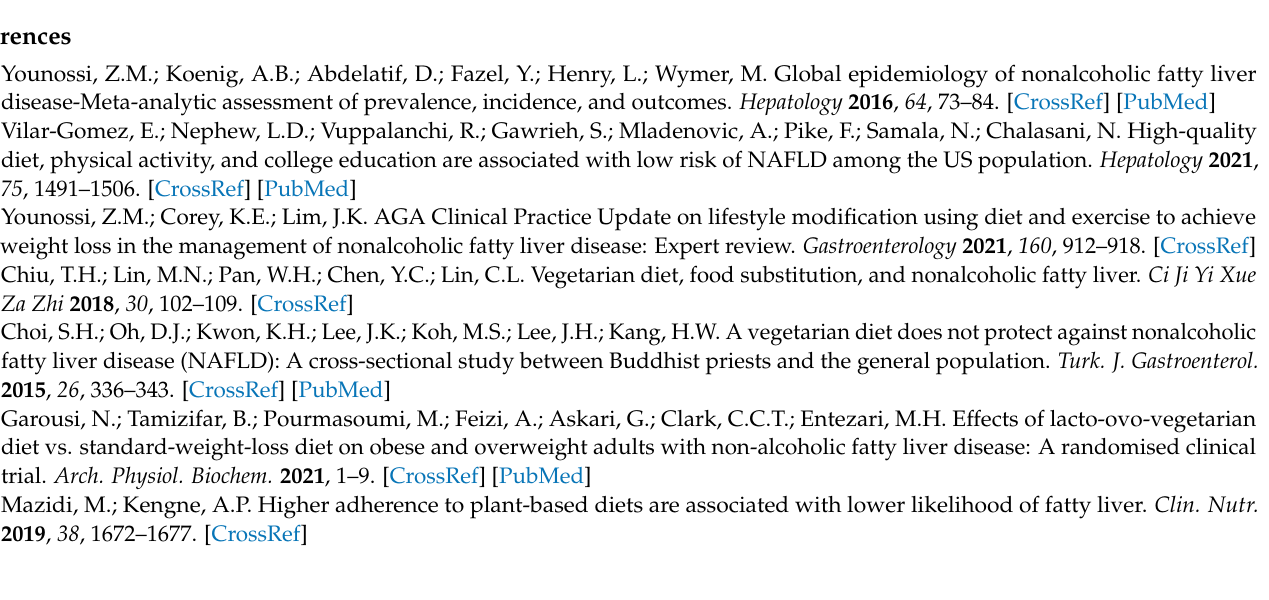
in the analysis. Table S1: Food components in three plant-based dietary indices. Table S2: Details of categorizations of the covariates. Table S3: Dietary intake of people according to adherence to the plant-based diets in NHANES (2017–2018). Table S4: Sensitivity analyses on the association between plant-based diets and odds of NAFLD using different cut-off value (CAP ≥ 288 dB/m). Table S5: Sensitivity analyses on the association between plant-based diets and odds of NAFLD defined by US fatty liver index (US FLI ≥ 30). Table S6: Sensitivity analyses on the association between plant-based diets and odds of NAFLD in people not having diabetes or prediabetes. Table S7: Sensitivity analyses on the association between plant-based diets and odds of NAFLD by treating the numerical covariates as continuous variables. Table S8: Sensitivity analyses on the association between plant-based diets and odds of NAFLD by additionally adjusting for waist circumference. Table S9: Sensitivity analyses on the association between plant-based diets and high NAFLD fibrosis score (NFS > 0.676) in NAFLD patients. Table S10: Sensitivity analyses on the association between plant-based diets and high fibrosis-4 index (FIB-4 > 3.25) in NAFLD